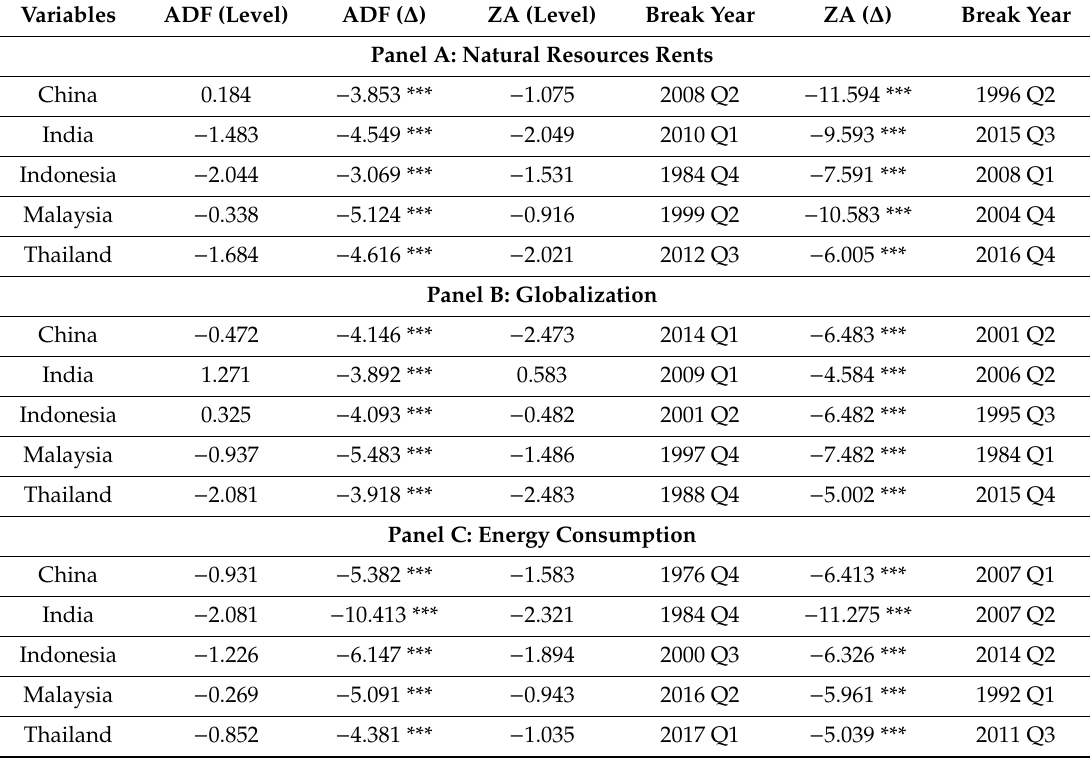
Table 3. Results of unit root test.